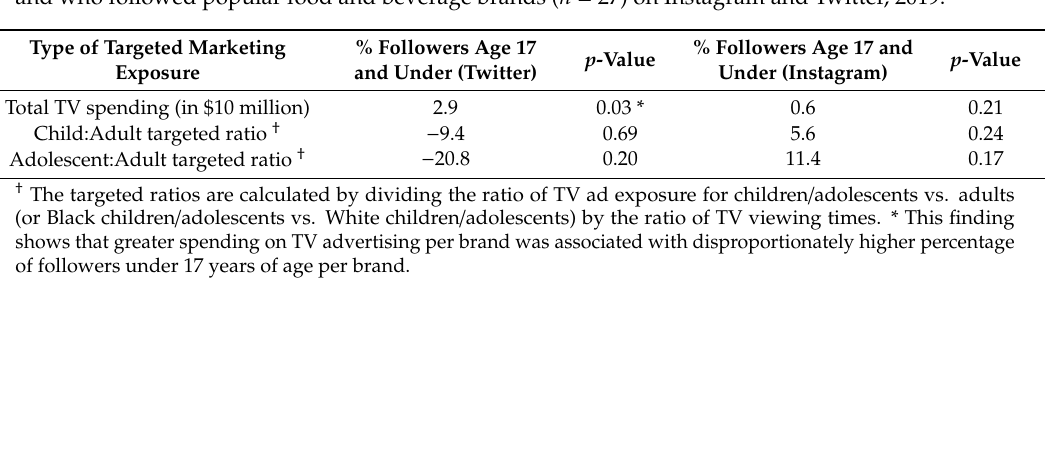
Table 4. Associations between targeted marketing and the percentage of users under 17 years of age and who followed popular food and beverage brands ( n = 27) on Instagram and Twitter,